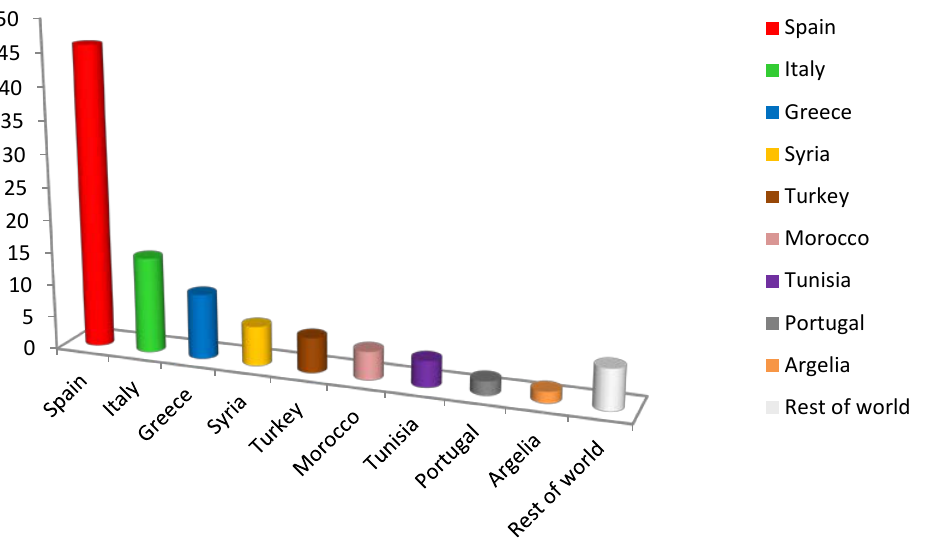
Figure 1. Olive oil production worldwide (data from International Olive Oil Council, IOOC 2014)